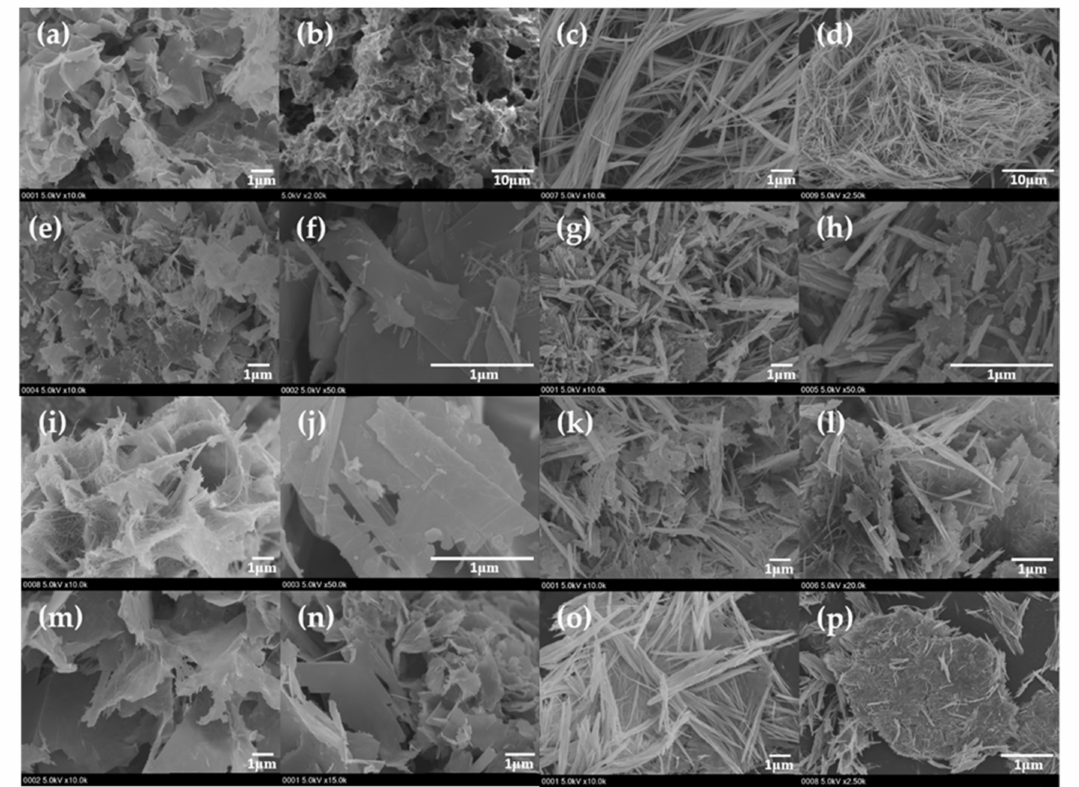
Figure 5. Scanning electron microscopy (SEM) images of the powdered manganese oxide minerals synthesized in the laboratory: ( a ) Oxi-BIR ( × 10,000), ( b ) Oxi-BIR ( × 2000), ( c ) Oxi-TOD ( × 10,000), ( d ) Oxi-TOD ( × 2500), ( e ) Rdx-BIR ( × 10,000), ( f ) Rdx-BIR ( × 50,000), ( g ) Rdx-TOD ( × 10,000), ( h ) Rdx-TOD ( × 50,000), ( i ) Rdx Mg -BIR ( × 10,000), ( j ) Rdx Mg -BIR ( × 100,000), ( k ) Rdx Mg -TOD ( × 10,000), ( l ) Rdx Mg -TOD ( × 20,000), ( m ) Red-BIR ( × 10,000), ( n ) Red-BIR ( × 15,000), ( o ) Red-TOD ( × 10,000), and ( p ) Red-TOD ( ×